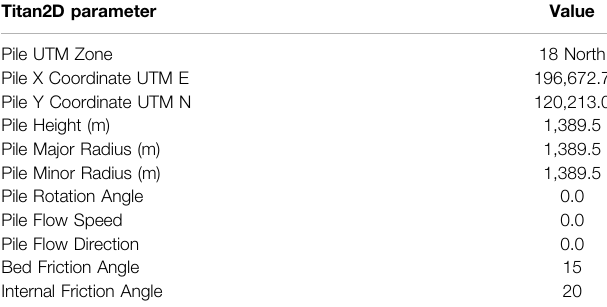
TABLE 3 | Titan2D eruption source parameters for Azufral volcano,